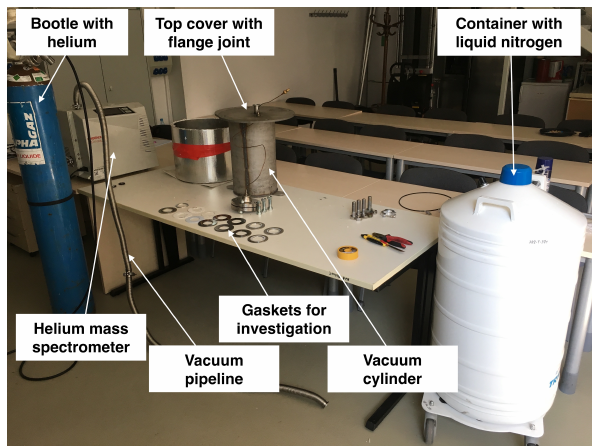
Figure 8: Experimental test rig to assess the leakage from the flanged